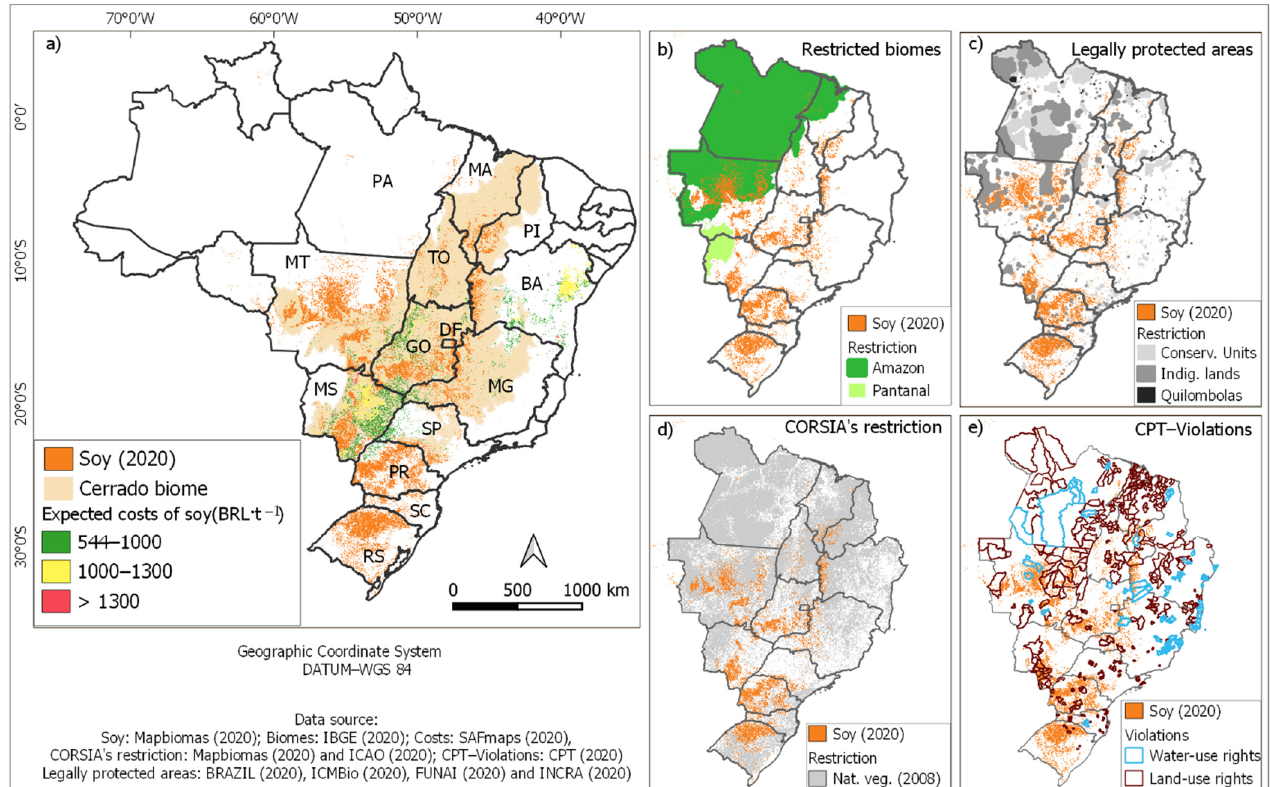
Figure 11. Soybean cultivation in 2020 in the Brazilian Cerrado and ( a ) the expected costs of soybean production in available areas for agriculture expansion. In this study, restrictions were imposed on ( b ) biomes, ( c ) legally protected areas, ( d ) CORSIA sustainability criteria, and ( e ) municipalities with reported violations on land-use and water-use rights.